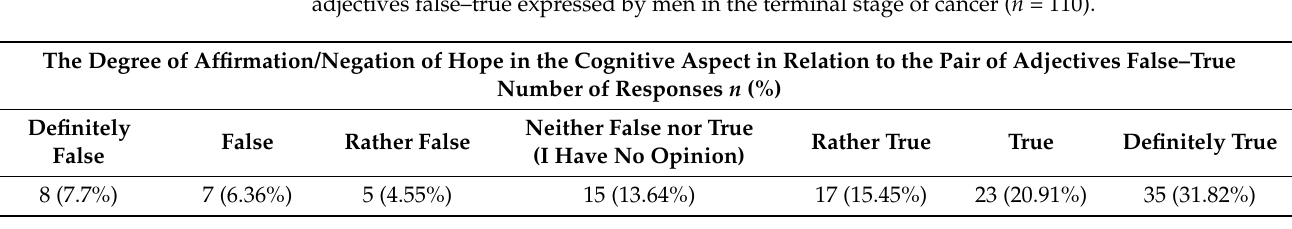
Table 4. The degree of affirmation/negation of hope in the cognitive aspect in relation to the pair of adjectives false–true expressed by men in the terminal stage of cancer ( n =